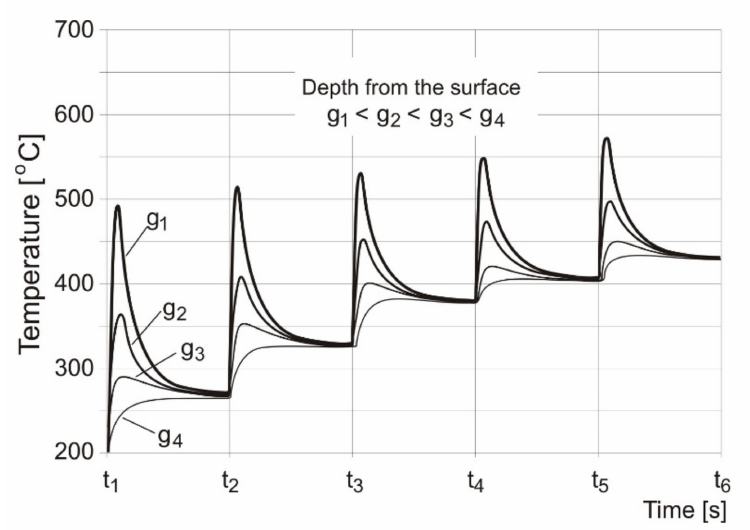
Figure 2. Changes of temperature at various distances g i from the die face in individual cycles of the forging process. Reprinted from permission from [15]. Copyright 2007 The Łukasiewicz Research Network—Institute for Sustainable